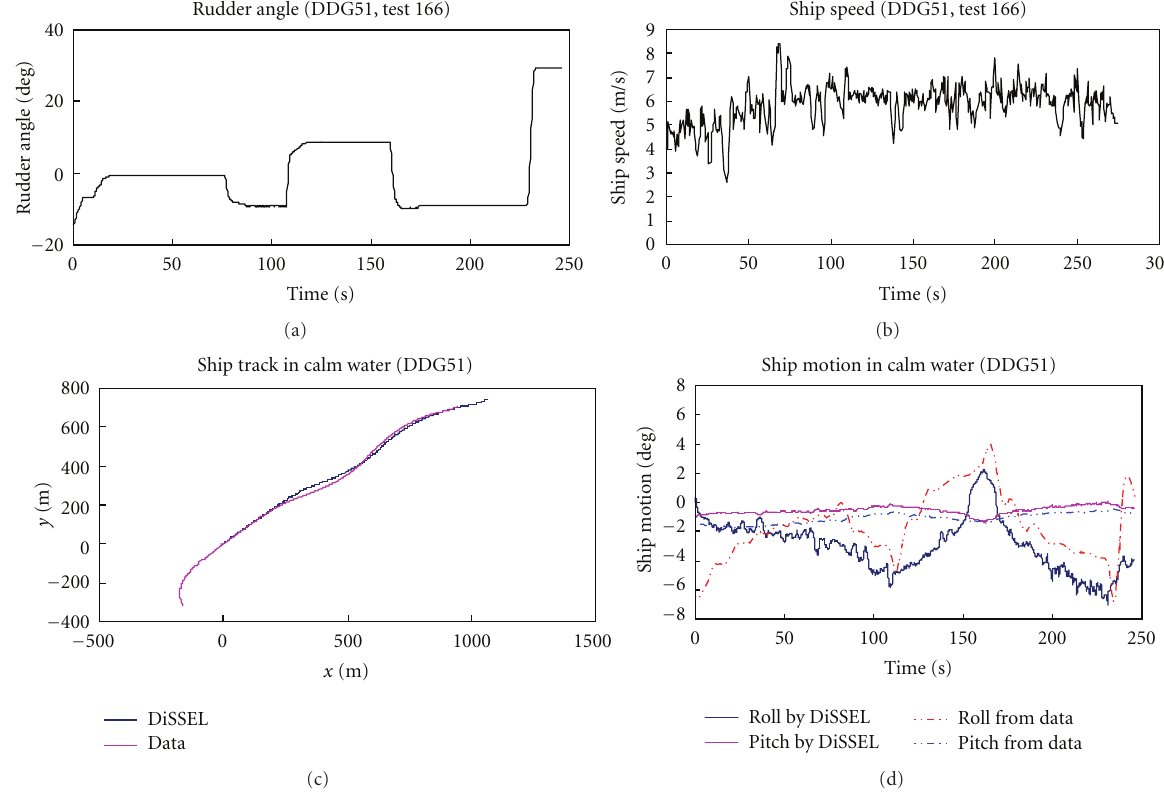
Figure 2: Data input for case 2 are shown in (a) and (b). (a) Rudder angle from data in test 166, (b) ship speed from data in test 166. Benchmark simulations for case 2 are shown in (c) and (d). (c) Comparison of ship track between simulation and experimental data in test 166. (d) Comparison of roll and pitch motions between simulations and data in test